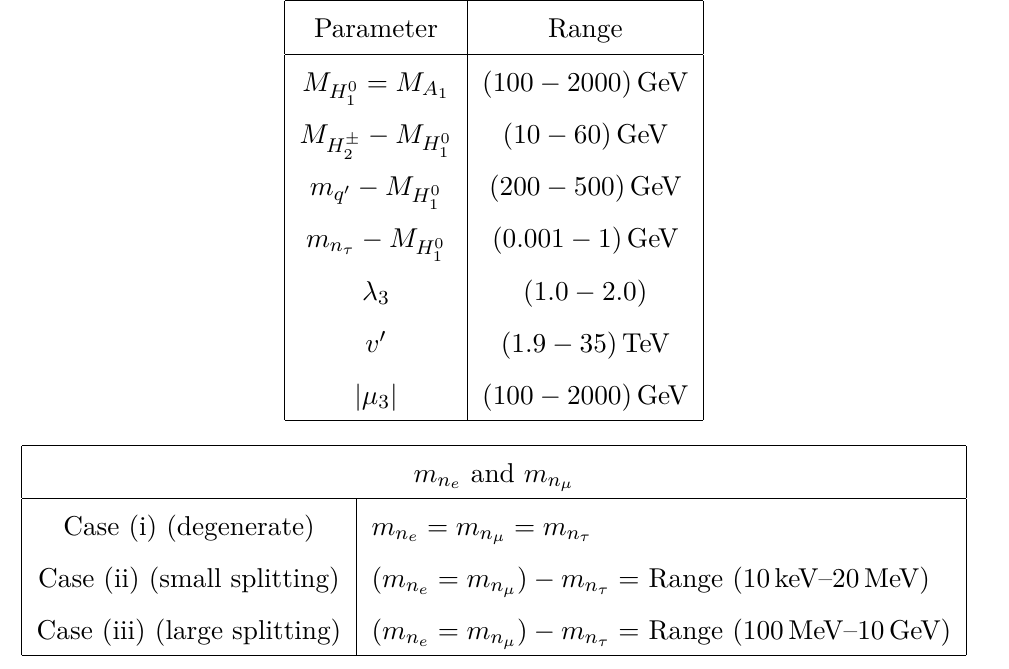
Table 3 . Range of masses considered for the scan in the scalar dark matter case, with q 0 = d 0 , s 0 , b 0 . Three different cases of neutrino mass hierarchy are considered. Choosing n τ as the lightest scotino enhances signals in the collider studies, as discussed in section